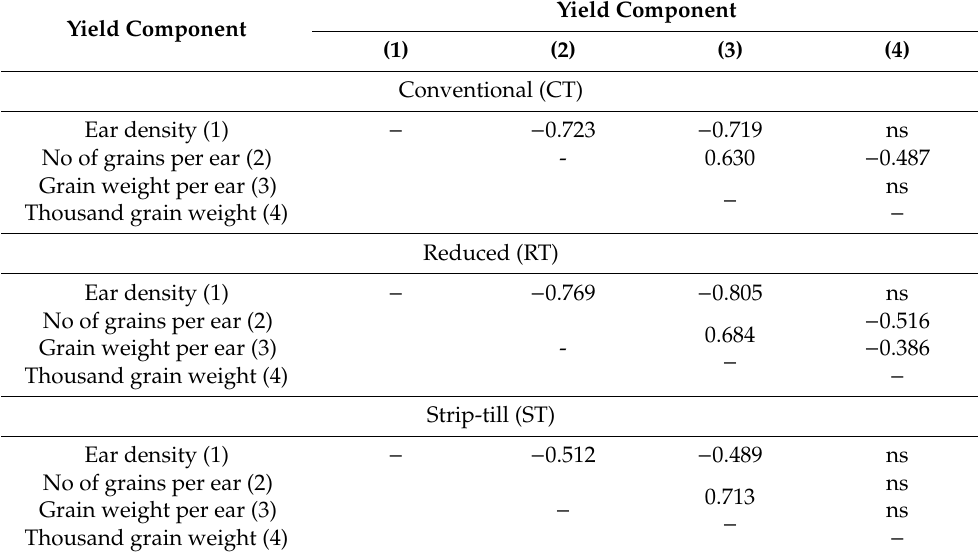
Table 3. Pearson’s correlation coe ffi cients between the yield components depending on the basic tillage, pre-sowing fertilisation, and winter wheat sowing technology ( N =